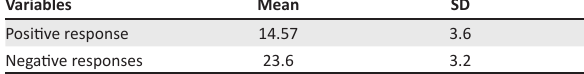
TABLE 4: Comparison of general mean responses for the population.